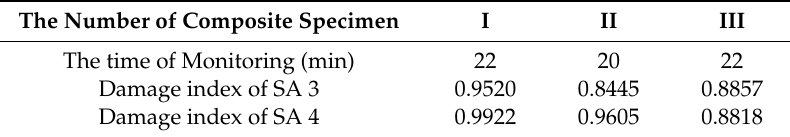
Table 2. Damage index of composite specimen at